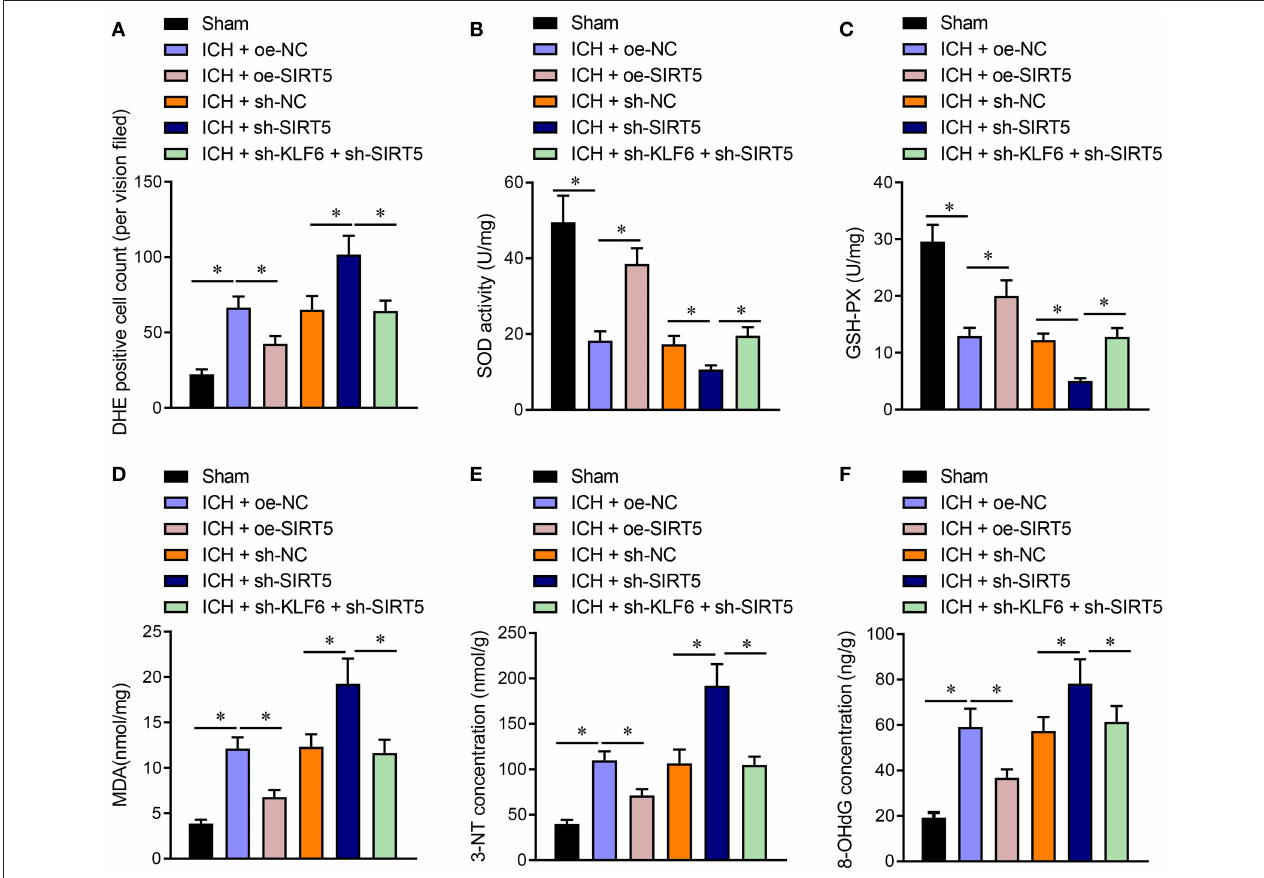
FIGURE 9 | KLF6 silencing depresses oxidative stress in ICH rats by inhibiting SIRT5-mediated Nrf2/HO-1 signaling pathway. ICH rats were infected lentiviruses carrying oe-NC, oe-SIRT5, sh-NC, sh-SIRT5, and sh-SIRT5 + sh-KLF6. (A) The active oxygen in the hippocampus of ICH rats determined by DHE staining. (B) SOD activity in hippocampal tissues of ICH rats. (C) GSH-Px activity in hippocampal tissues of ICH rats. (D) MDA level in hippocampal tissues of ICH rats. (E) 3-NT concentration in hippocampus of ICH rats determined by ELISA. (F) 8-OHdG concentration in hippocampus of ICH rats determined by ELISA. n = 6 rats/group, * p < 0.05. The measurement data were expressed as mean ± standard deviation. Comparisons between two groups were analyzed using unpaired t -test, and comparisons among multiple groups were tested by one-way ANOVA followed by Dunnett post-hoc